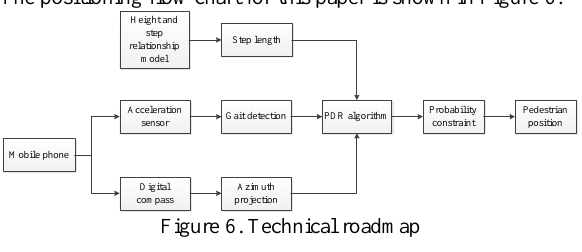
Figure 6. Technical